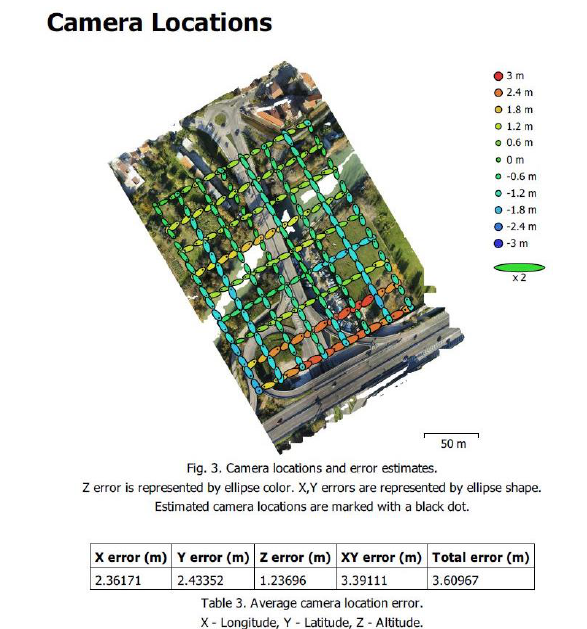
Figure 13: auto-correction on the camera that the program applies to obtain the model related to reality.